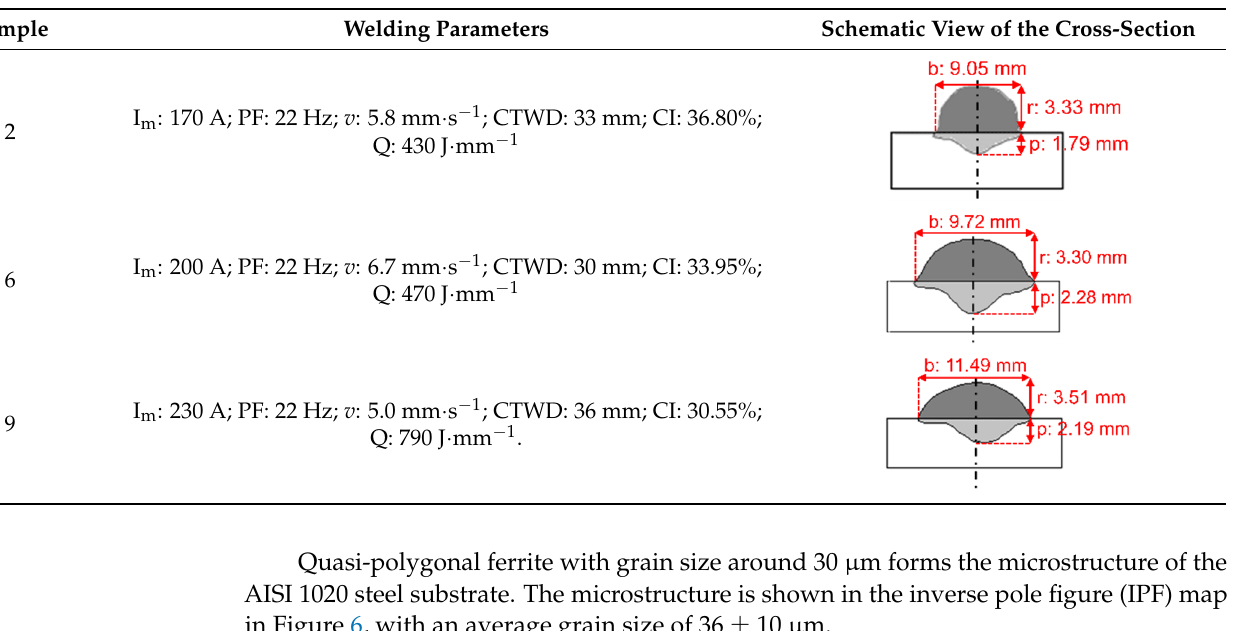
Figure 6. Inverse pole figure (IPF) map of the AISI 1020 base metal.